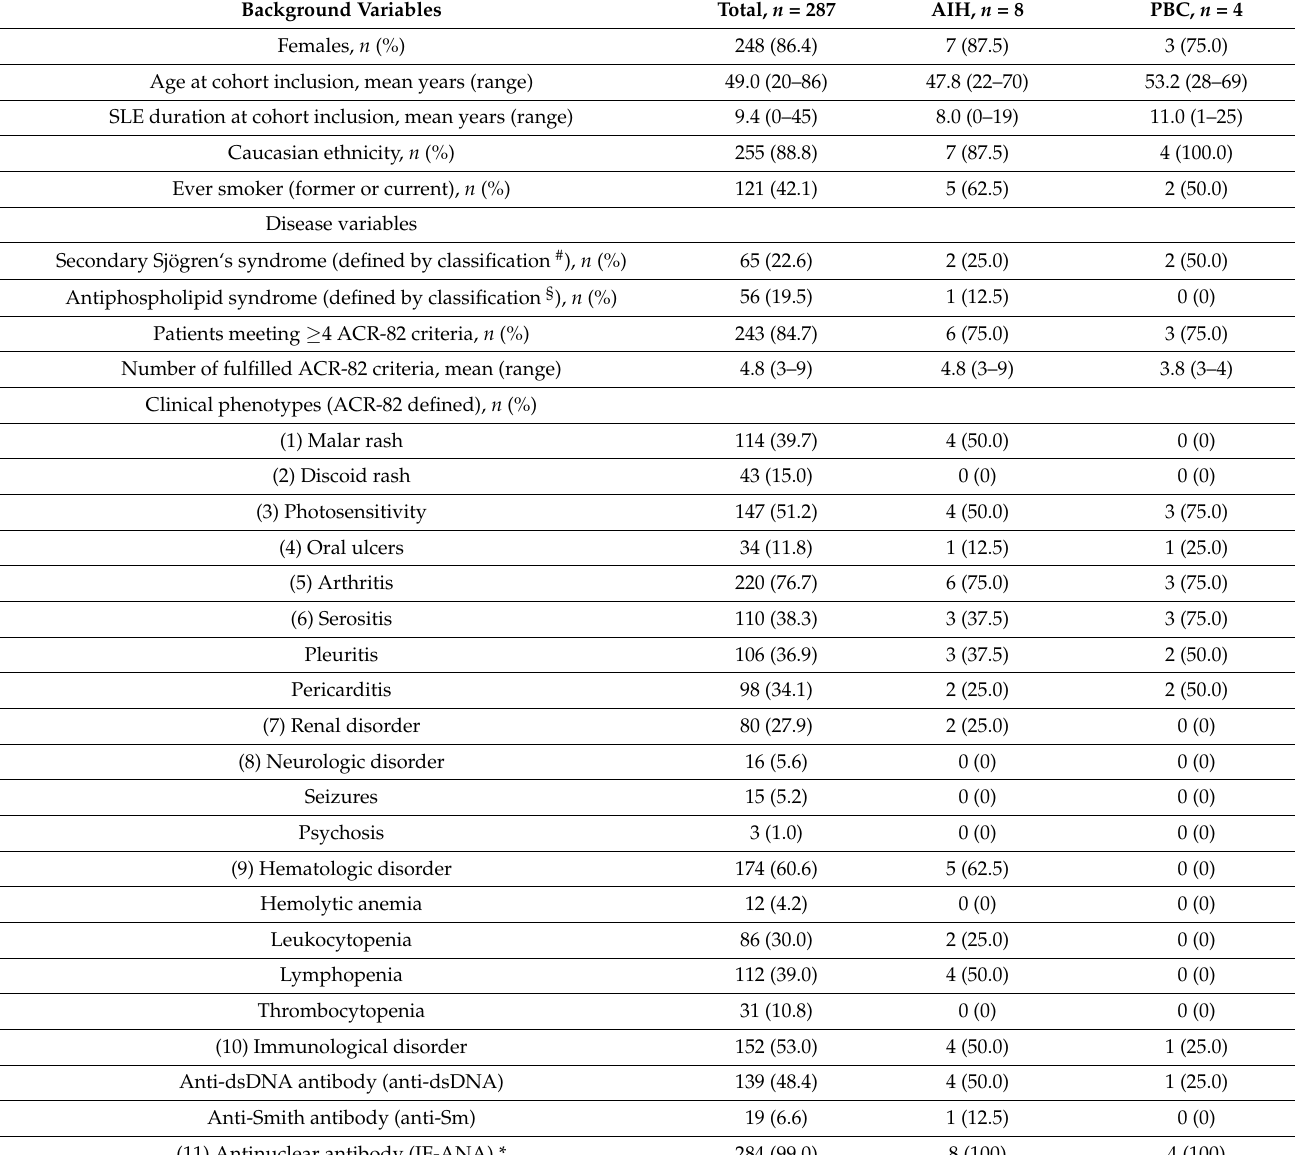
Table 1. Characteristics of the included patients with SLE. Patients with confirmed AILD are shown in separate